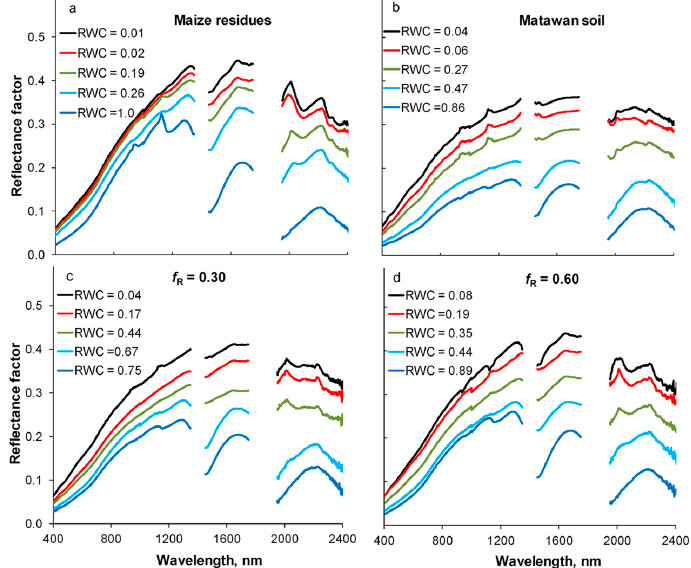
Figure 8. Field reflectance spectra of ( a ) maize residues, ( b ) Matawan soil, ( c ) 0.30 residue cover ( f R ) and ( d ) 0.60 f R at various RWC. Maize residue spectra are from scenes with f R > 0.95, whereas Matawan soil spectra are scenes with f R < 0.02. The remaining two graphs represent scenes with maize f R = 0.30 ± 0.03 and f R = 0.60 ±